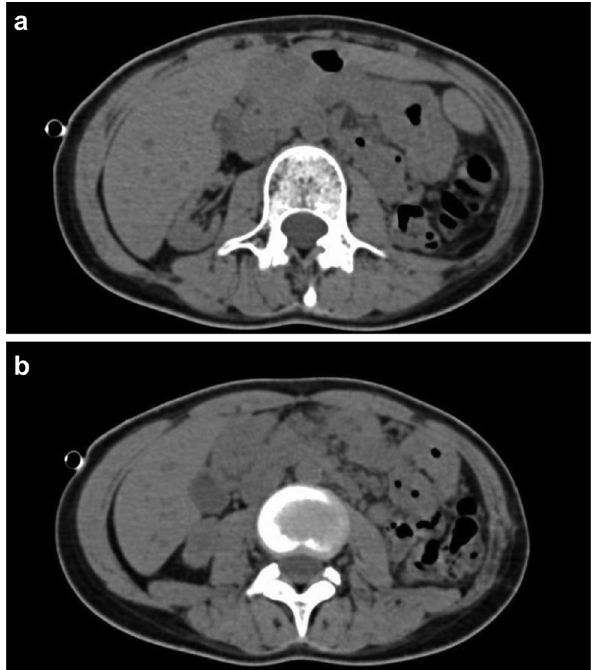
Figure 1: Abdominal computerized tomography images showing ( a ) left renal agenesis and ( b ) right renal